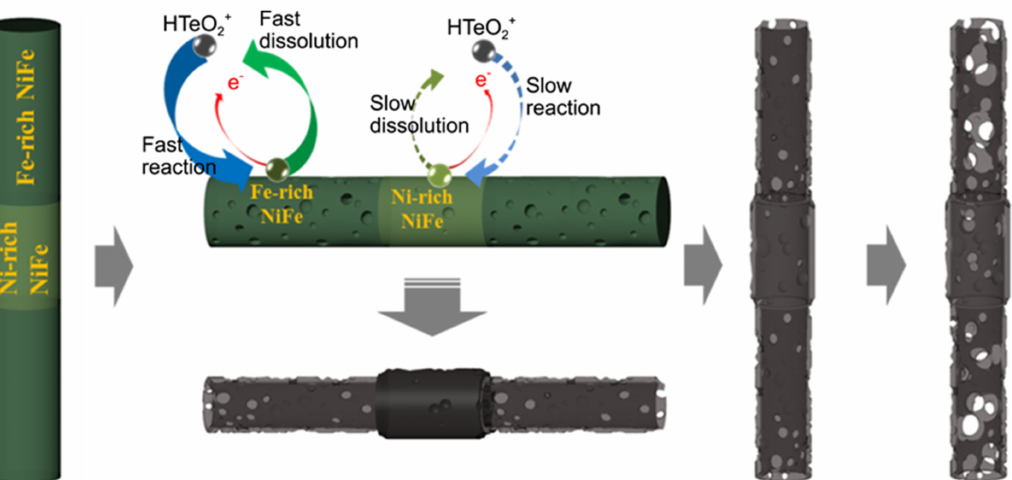
Figure 2. Schematic diagram of the bamboo-shaped Te NTs produced by the galvanic displacement reaction of a segmental NiFe nanowire with Ni-rich and Fe-rich NiFe segments in an electrolyte consisting of HTeO 2+ ions in acidic HNO 3 solution. Reprinted with permission from [11]. Copyright 2014, Wiley-VCH Verlag GmbH & Co. KGaA, Weinheim,